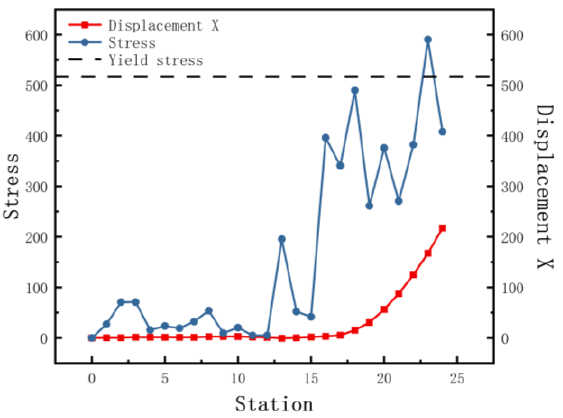
Figure 9. The equivalent von Mises stress and displacement X with stations. Table 4. Different inter-distance cases.